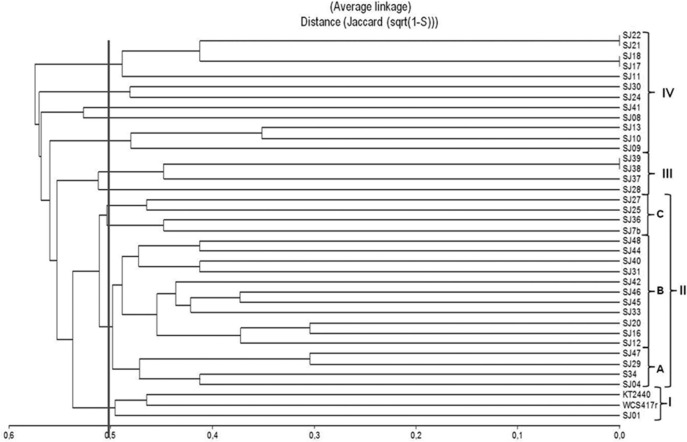
Dendrogram based on ERIC-PCR profiles, generated from native, and reference Pseudomonas strains using the UPGMA algorithm and Jaccard coefficient.